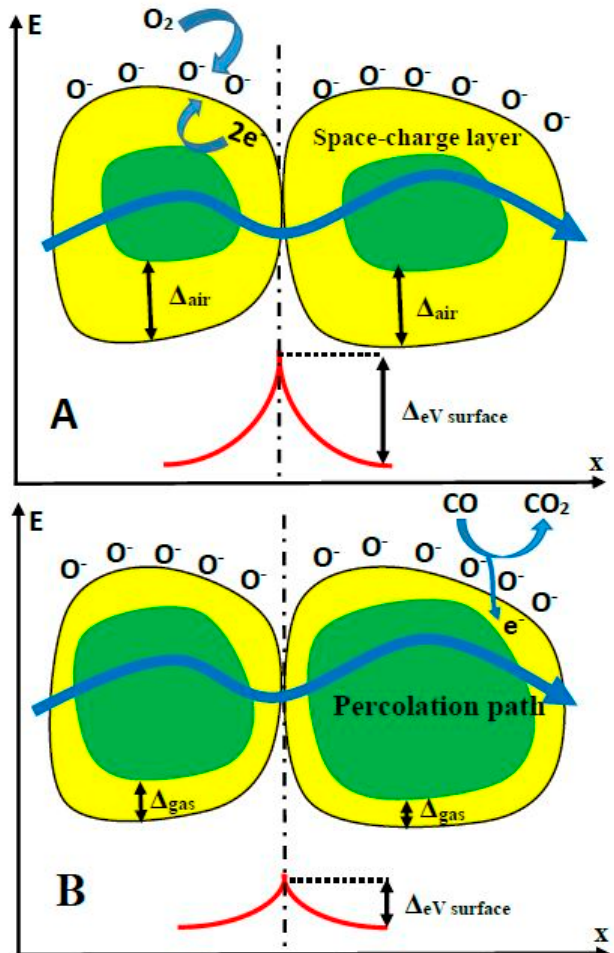
Figure 3. Structural and band models of conductive mechanism upon exposure to CO gas. ( A) in the absence of CO, ( B) in the presence of CO.